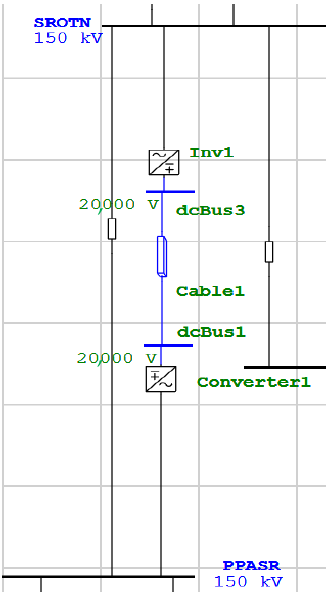
Figure 5. Placement of the HVDC Transmission System at Paya Pasir (Bus 5)–Sei Rotan (Bus 11).